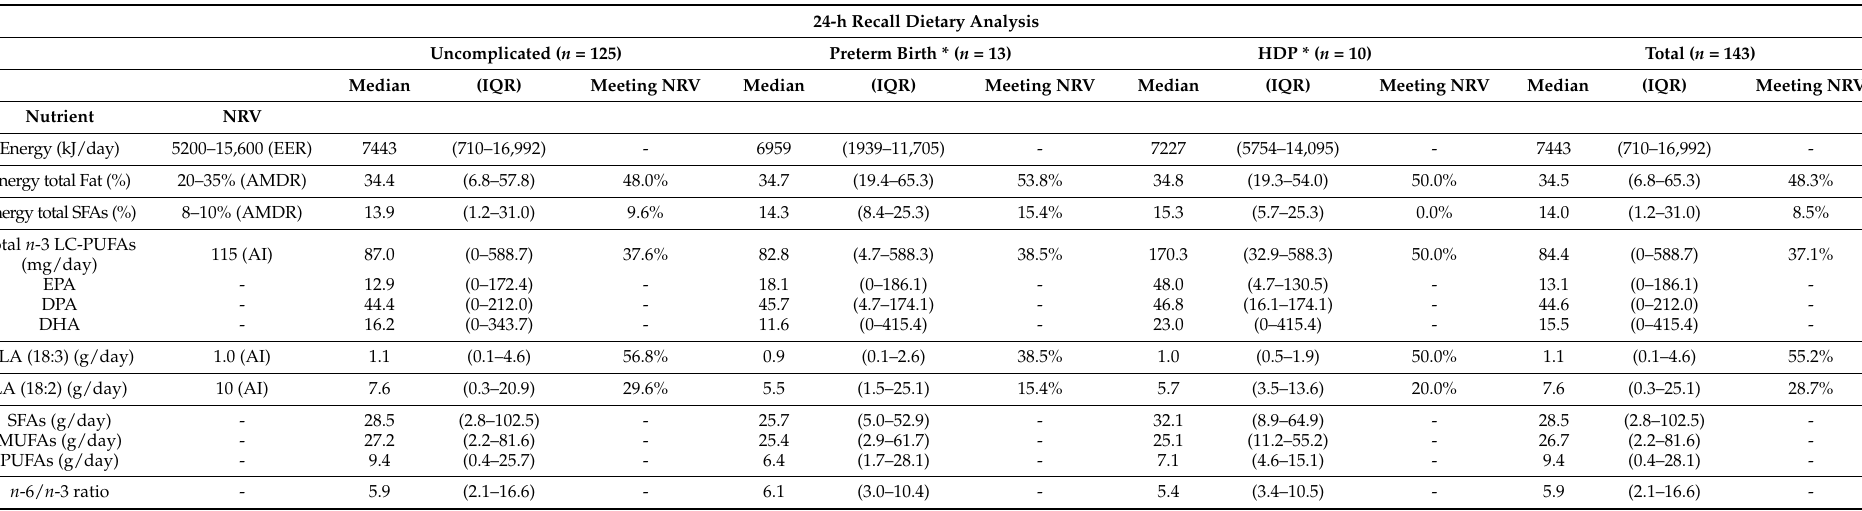
Table 3. Comparison of nutrient intake from foods and supplements ˆ of pregnant women in the Gomeroi Gaaynggal cohort with or without a preterm birth or hypertension during pregnancy, as recorded by 24-h recall.